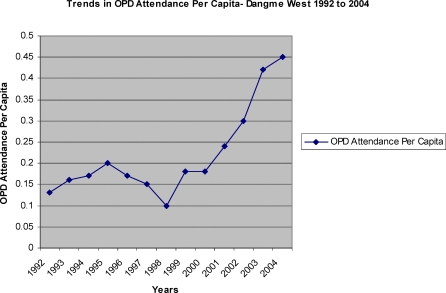
Trends in OPD Attendance Per Capita in Dangme West, 1992–2004